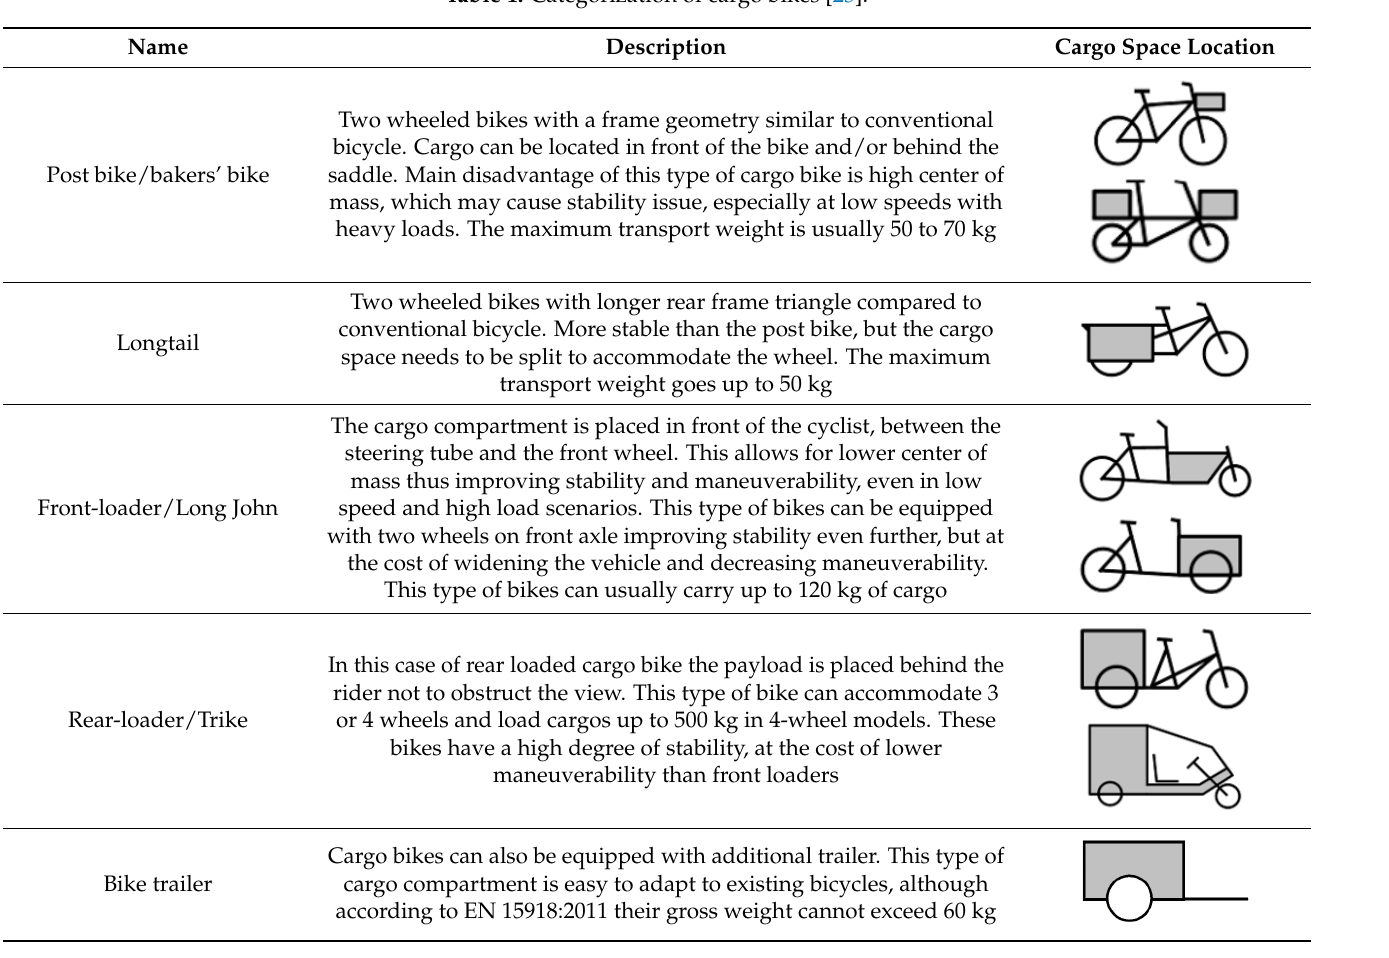
Table 1. Categorization of cargo bikes Table 1. Categorization of cargo bikes [23]. Table 1. Categorization of cargo bikes [23]. Table 1. Categorization of cargo bikes [23]. Table 1. Categorization of cargo bikes [23]. Table 1. Categorization of cargo bikes [23].